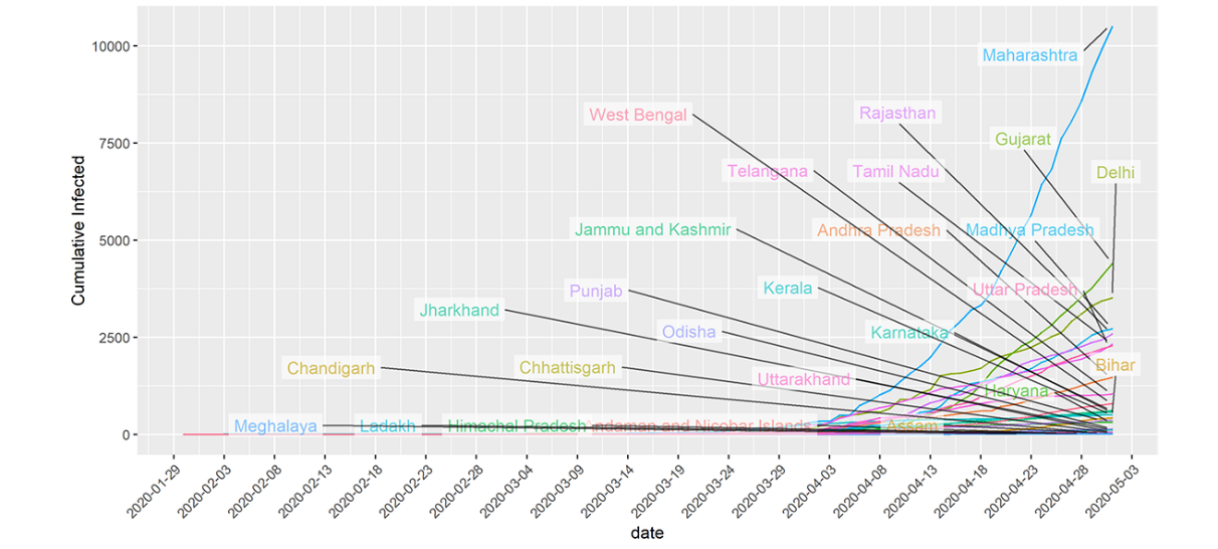
Figure 3. Cumulative number of infected people over time in states with at least 10 infected